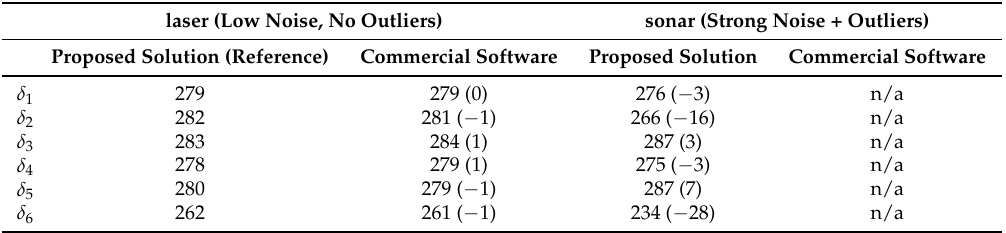
Table 2. Comparison of inter-rung distance ( δ i ) estimations obtained with our orthogonal simultaneous fitting algorithm (without distance prior) and a commercial solution (3DReshaper sonar point clouds of the ladder. Distances are in millimeters.